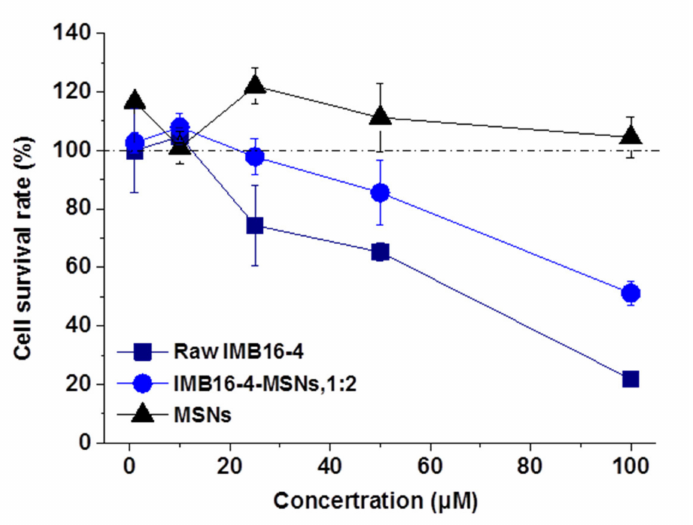
Figure 7. The cell survival rate of LX-2 cells at varying concentrations of raw IMB16-4-MSNs and IMB16-4-MSNs (1:2). Each data point represents the mean ± SD of three